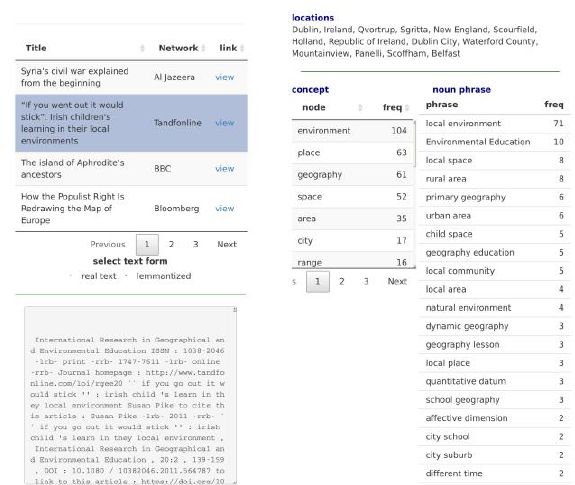
Figure 2. Extraction of locations, spatial concepts, and